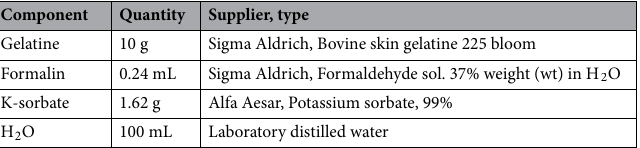
Table 2. Components and concentration used for the background of the phantom per 100 mL of distilled water.